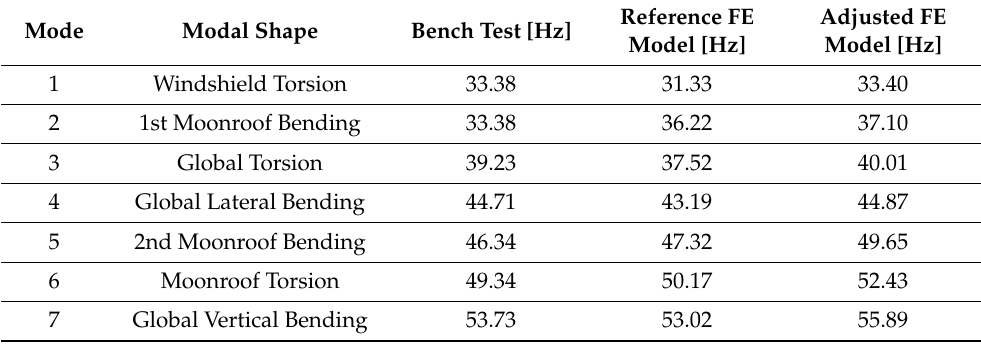
Table 4. Eigenfrequencies of the bench test and the reference and adjusted FE models of the vehicle body structure.